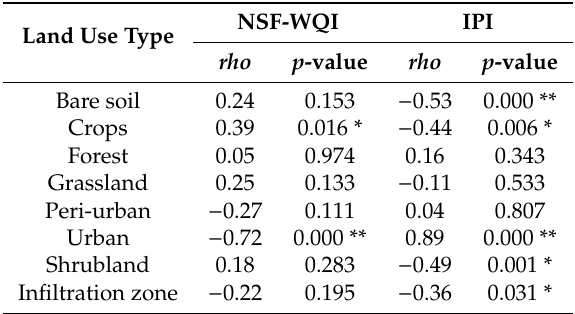
Table 10. Statistical analysis (Spearman’s rho) of each of the water quality indices (NSF-WQI and IPI) and the corresponding land use (% of total area) in the whole catchment, 1991–2017. NSF-WQI IPI Land Use Type rho p -value rho p -value Bare soil 0.24 0.153 − 0.53 0.000 ** Crops 0.39 0.016 * − 0.44 0.006 * − 0.27 − 0.72 0.001 * − 0.22